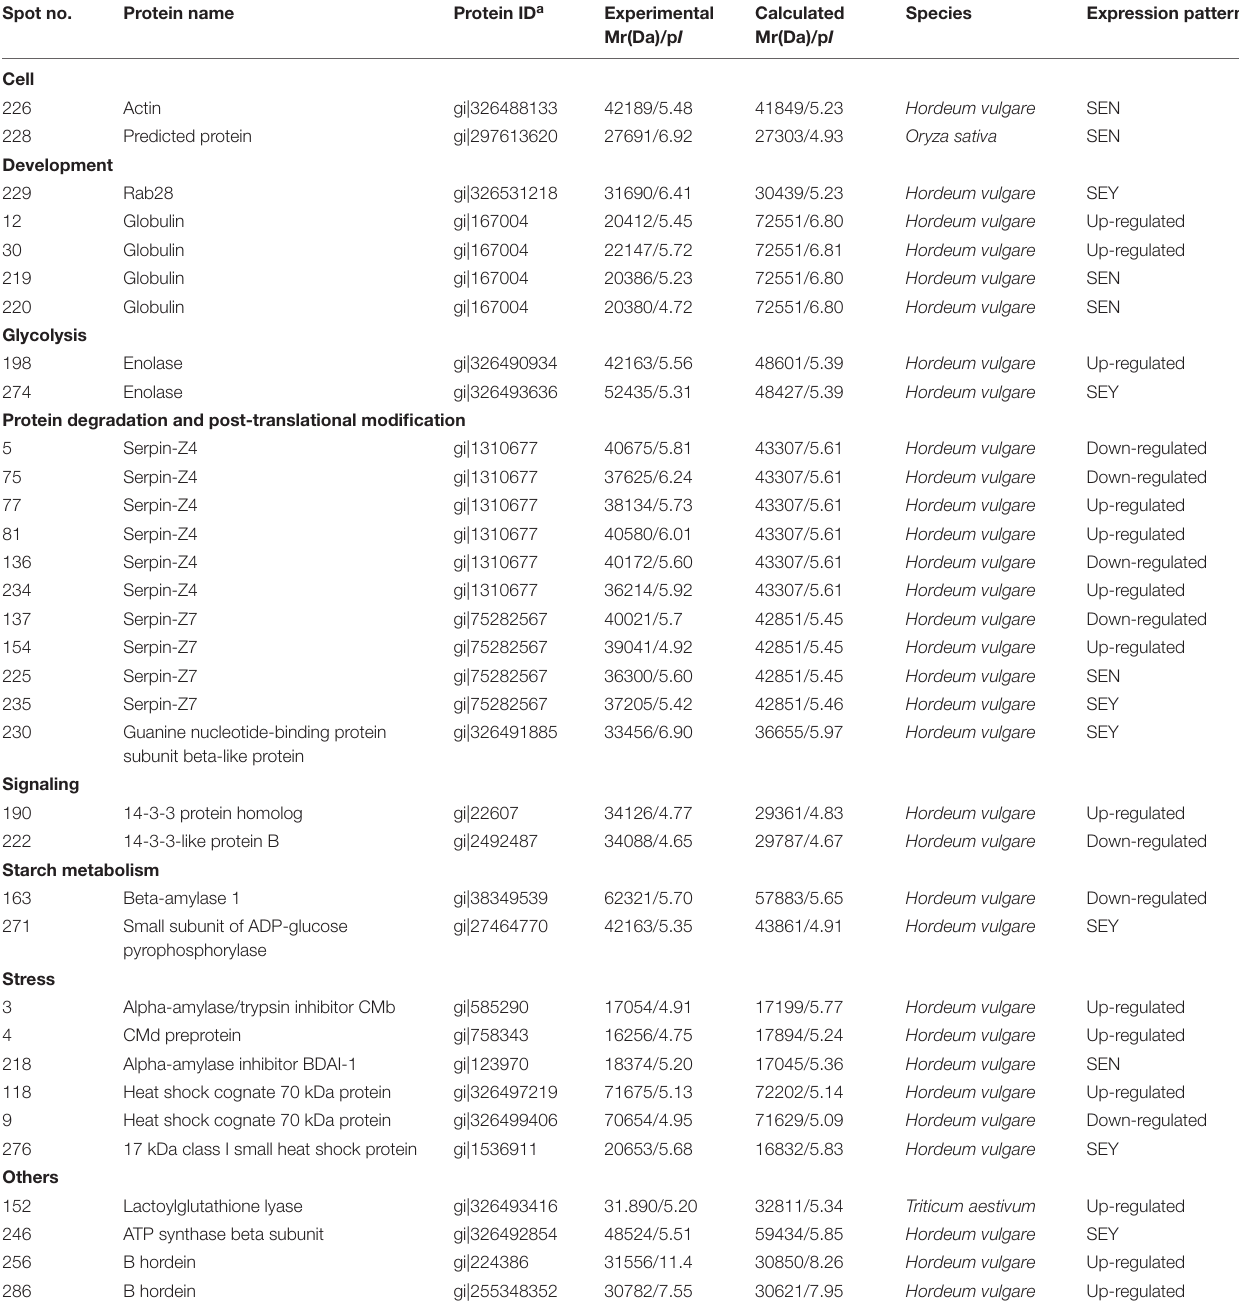
TABLE 1 | Identified differentially expressed proteins between Yangsimai3 and Naso Nijo in mature barley grains. Spot